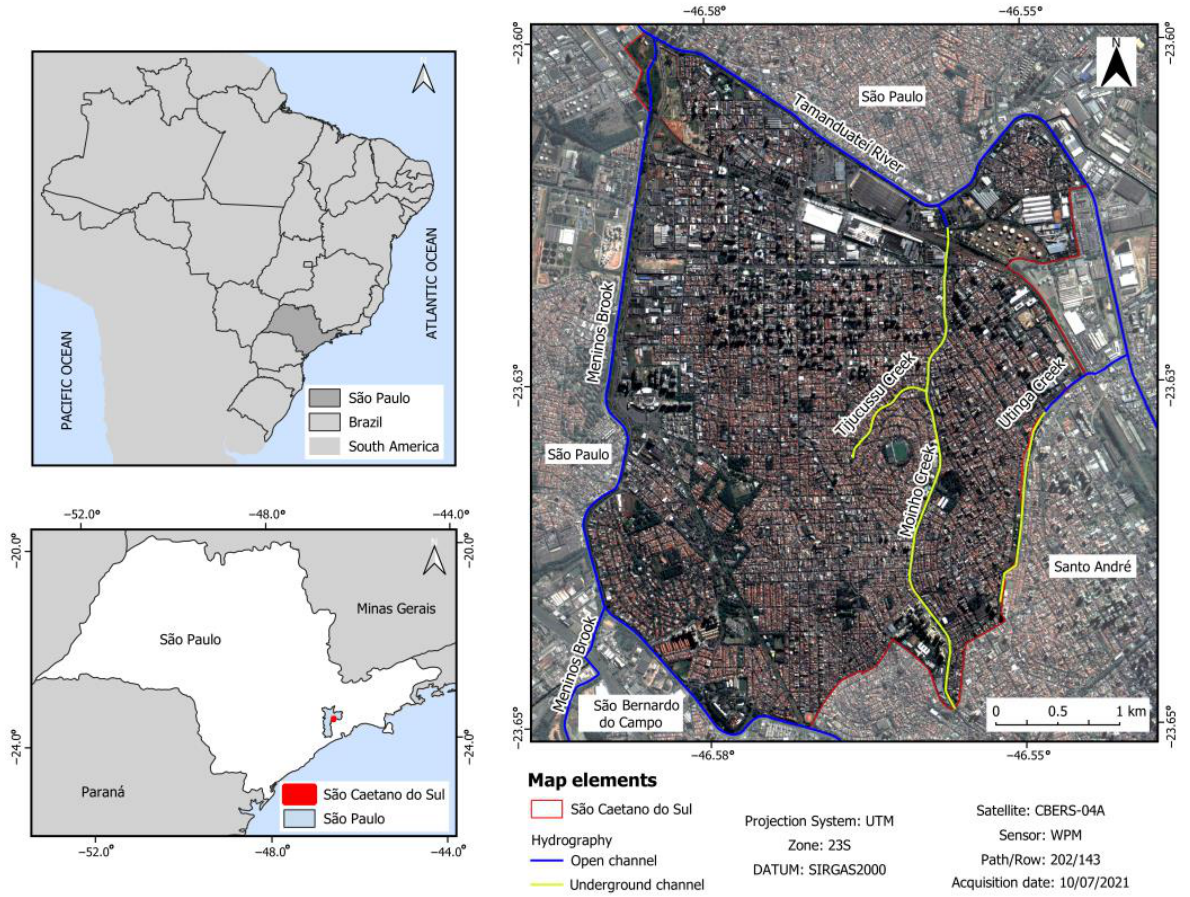
Figure 1. Location map of the study area.